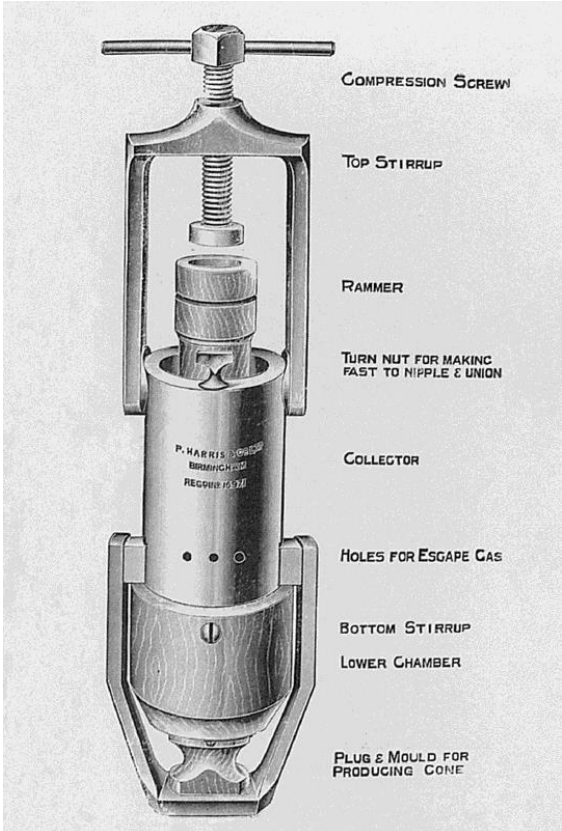
Figure 2. Carbon dioxide snow collector and compressor, as demonstrated by Hall-Edwards 1913 (reproduced from the Wellcome Library, London, used under a Creative Commons Attribution 4.0 International License).